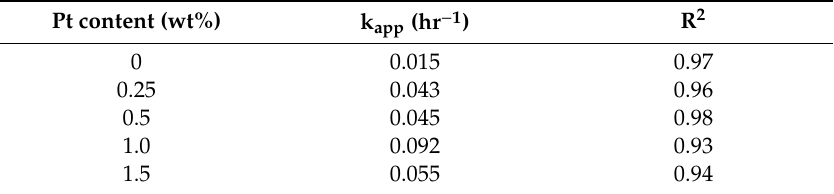
Table 3. Kinetic parameters (rate constants and linear regression coefficients R 2 ) for photocatalytic degradation of pirimicarb at various Pt contents.